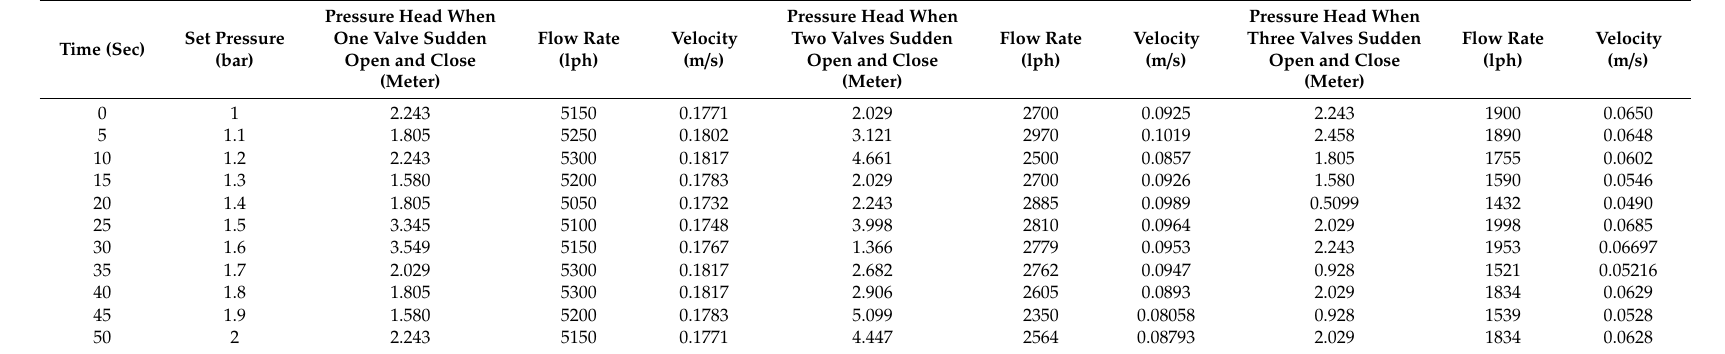
Table 1. Real-time data from the